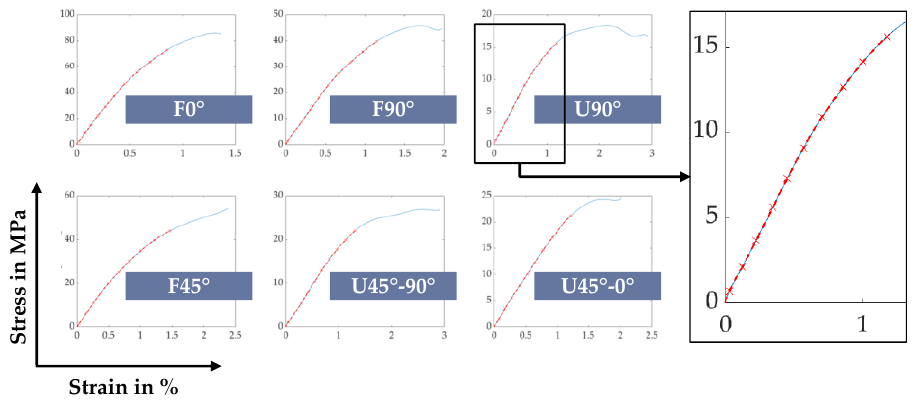
Figure 7. Results of the detection of linear area within experimental averaged results.